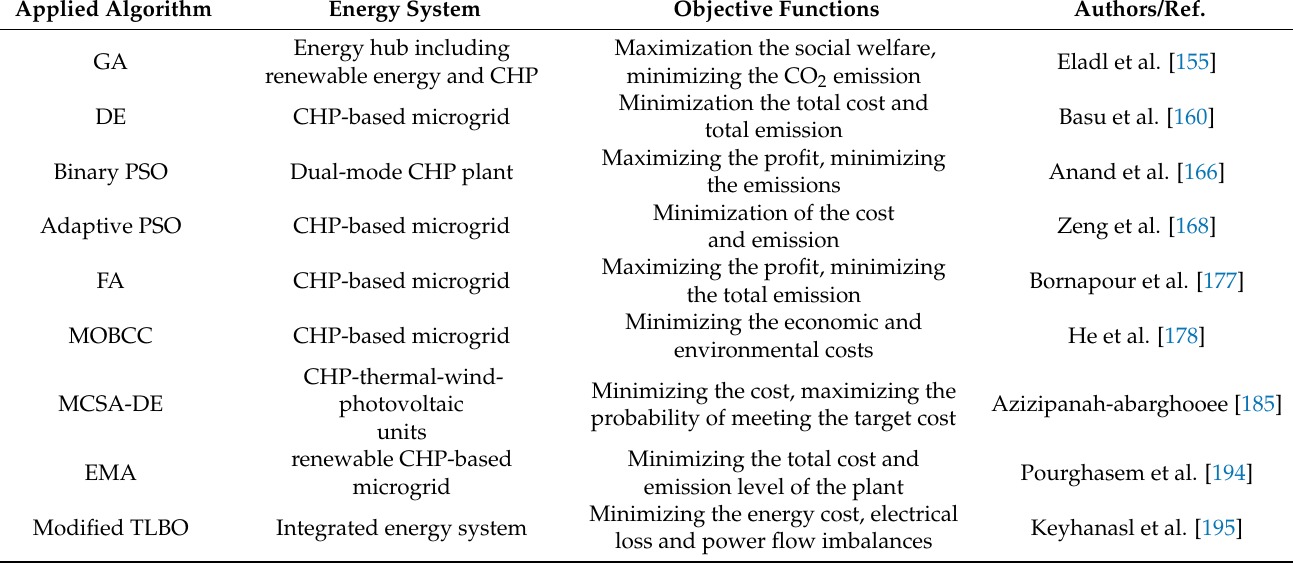
Table 7. Multi-objective scheduling issues of CHP energy